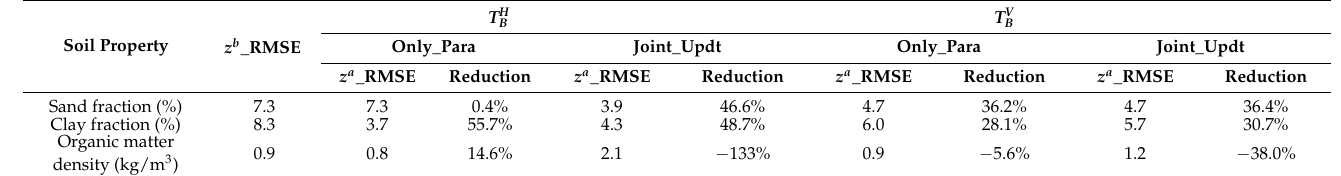
Table 5. RMSE values of the retrieved soil properties of the first layer in the two data assimilation